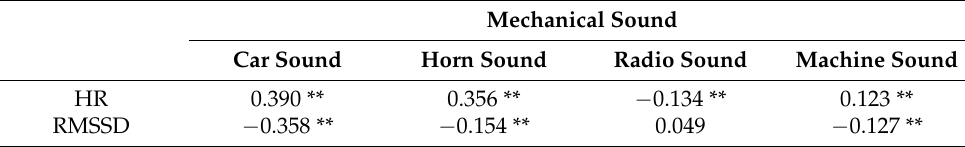
Table 8. Pearson correlation between park mechanical sound and heart rate